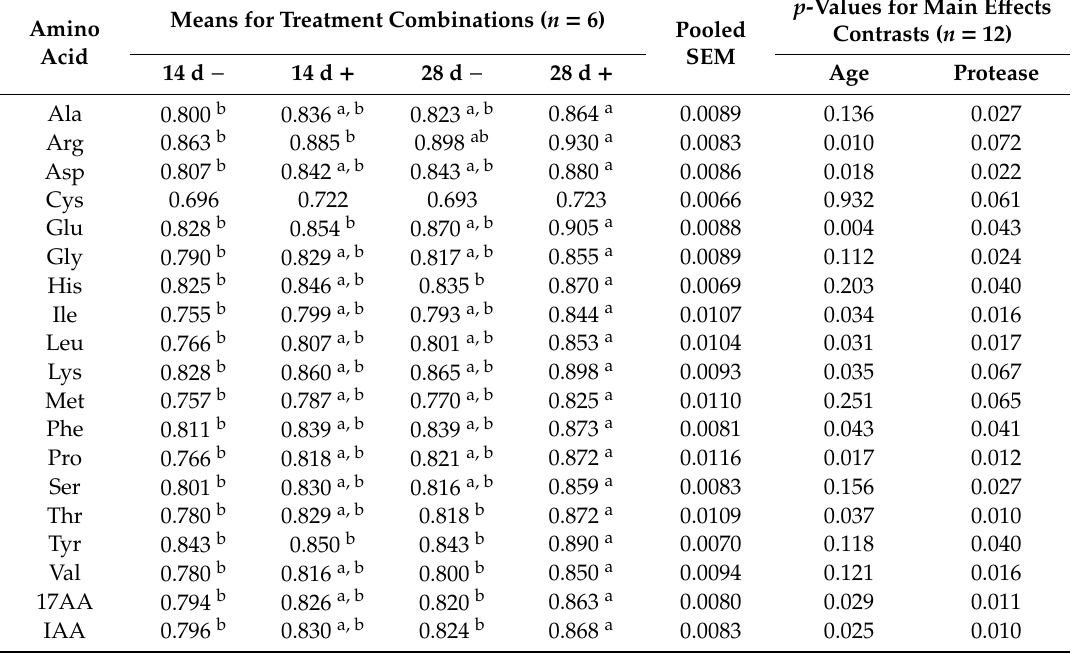
Table 7. Standardised ileal digestibility of amino acids in the seeds of the coloured-flowered pea